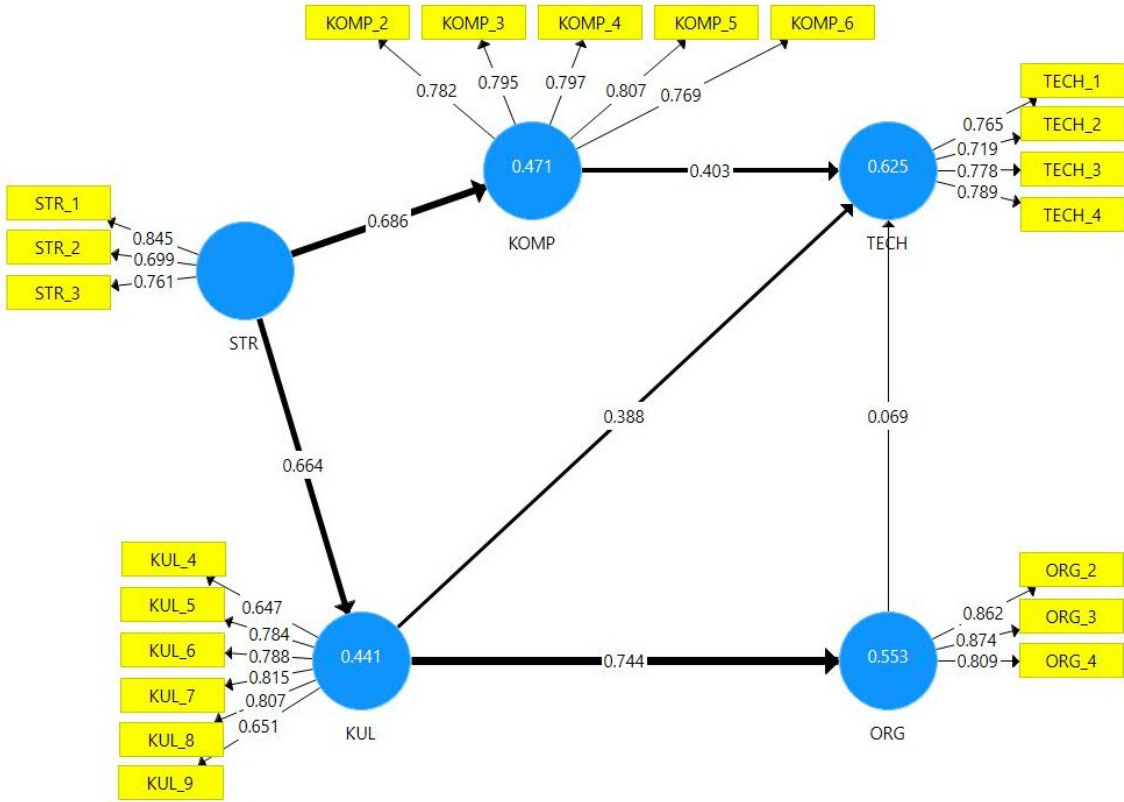
Figure 2. Structural model of dependencies between constructs (dimensions of the OeHR research model). *Figure description: (i) circles represent constructs; (ii) rectangles represent measurable variables (indicators); (iii) values given on the arrows between the indicators and the constructs represent factor loadings; (iv) values given on the arrows between constructs represent path coefficients (i.e., standardized regression coefficients); (v) values given inside the hidden constructs indicate the coefficients of determination R 2 .